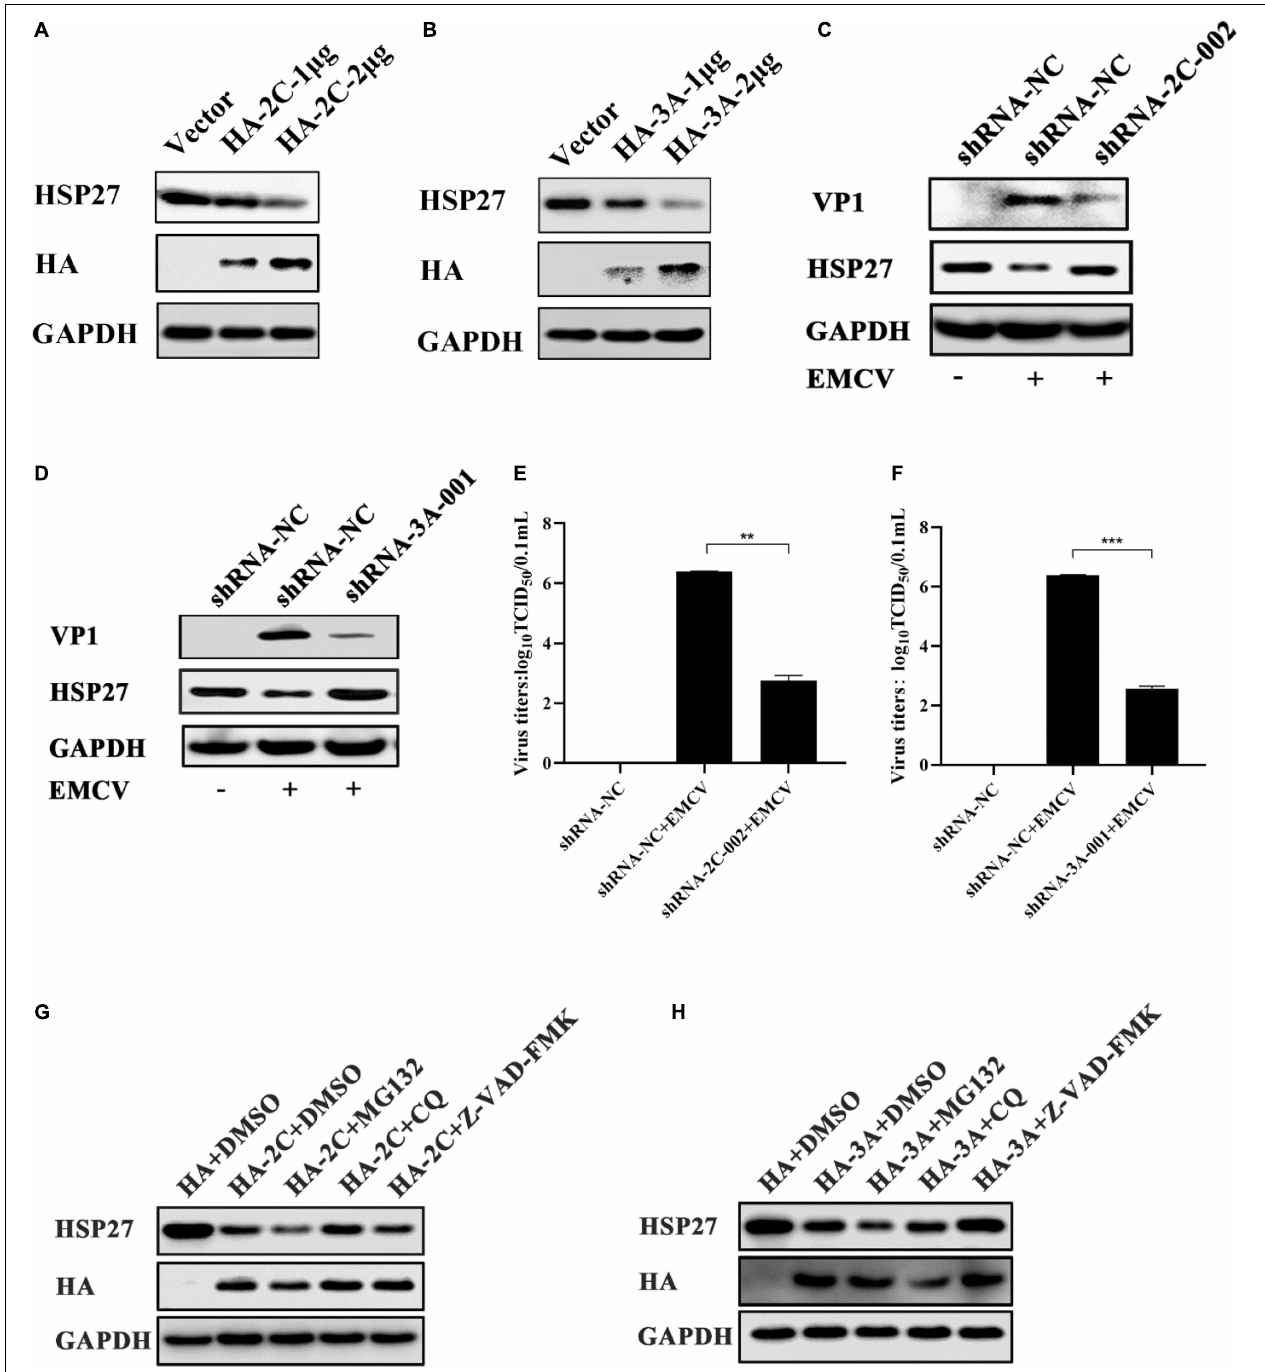
FIGURE 2 | Encephalomyocarditis virus (EMCV) degrades HSP27 protein via 2C pro and 3A pro . (A) A549 cells were transfected with increasing doses of HA-2C (1.0 and 2.0 µ g). Immunoblotting was used to analyze HA tag and endogenous HSP27 protein expression. GAPDH was used as a loading control. (B) A549 cells were transfected with increasing doses of HA-3A (1.0 and 2.0 µ g). Immunoblotting was used to analyze HA tag and endogenous HSP27 protein expression. GAPDH was used as a loading control. The stable knockdown A549 cell lines of viral 2C pro (shRNA-2C-002) or the stable knockdown A549 cell lines of viral 3A pro (shRNA-3A-001) and shRNA-NC cell lines were infected with EMCV at an multiplicity of infection (MOI) of 0.01 for 36 h. (C,D) Immunoblotting was used to measure VP1 and HSP27 protein expression, respectively. GAPDH was used as a loading control. (E,F) Viral titers were measured by TCID 50 assay. (G,H) A549 cells were transfected with HA-2C or HA-3A (1.0 µ g) and then treated with MG132 (10 µ M), chloroquine (CQ) (50 µ M) or Z-VAD-FMK (20 µ M) or DMSO for 6 h, respectively. The expression of HA tag and HSP27 protein were detected by immunoblotting. GAPDH was used as a loading control. Data were represented as mean ± SD of three independent experiments and were measured in technical duplicate, ** P < 0.01 and *** P < 0.001.